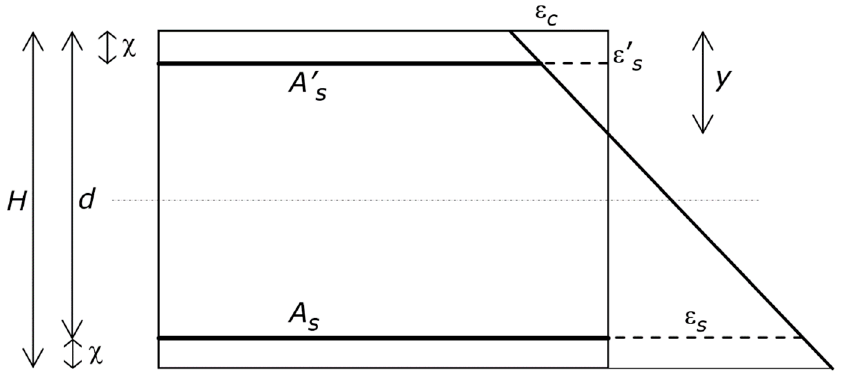
Figure 1. Reference structure. Geometric characteristics and strain profile, including the relevant symbols. The figure shows the depth of the neutral axis y , the tension and compression longitudinal reinforcements, whose areas are A s and A ’ s , respectively, the maximum strain in the concrete, which is ε c , and the strain in the tension and compression reinforcements, which are ε s and ε ’ s , respectively.